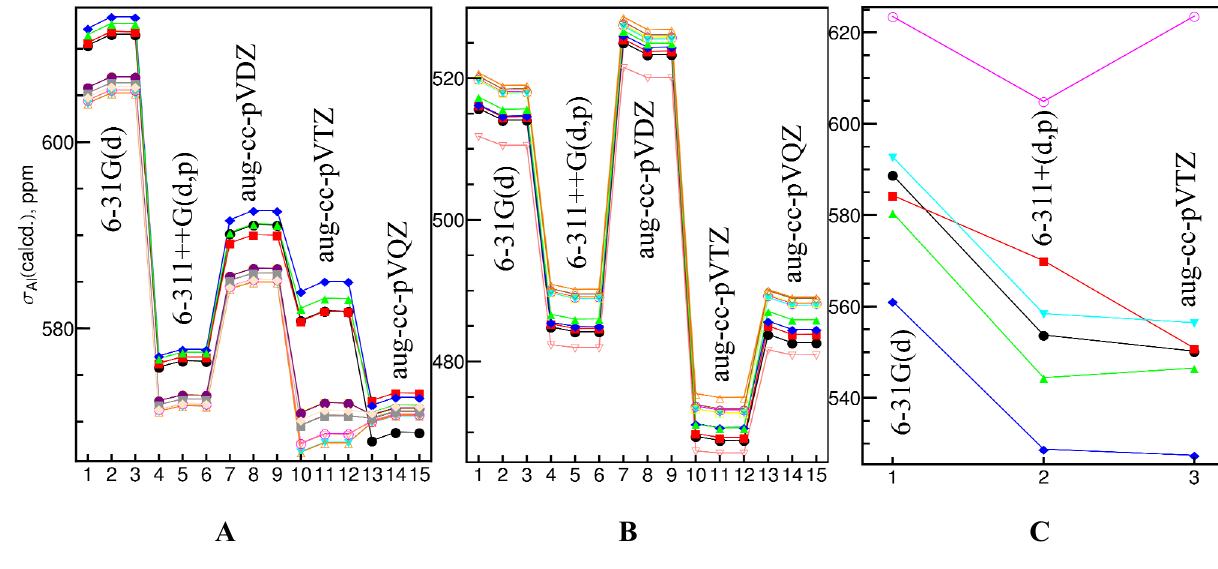
Figure 2. Calculated 27 Al shielding constants using the GIAO method with the B3LYP ) ] 3+ ( A ), functional with different basis sets in optimized geometries of [Al(OH 2 6 [Al(OH) ] − ( B ) and other complexes ( C ). The basis sets were labeled on the graphs. In 4 Panels A and B , there are three data points for each basis set which represent the values calculated in vacuum, in the PCM environment of water and methanol. Twelve geometries in A were obtained at the B3LYP/aug-cc-pVQZ, B3LYP/aug-cc-pVTZ, B3LYP/aug-cc-pVDZ and B3LYP/6-311++G(d,p) levels in vacuum, in the PCM environment of methanol and water, and the data sets are colored in black, red, blue, green, cyan, magenta, yellow, brown, orange, pink, purple and gray, respectively. The last geometry in A , which is in light orange color, was obtained at the B3LYP/6-31G(d) level in the PCM environment of water. Ten geometries in B were obtained at the B3LYP/aug-cc-pVQZ, B3LYP/aug-cc-pVTZ, B3LYP/aug-cc-pVDZ and B3LYP/6-311++G(d,p) levels in vacuum, at the B3LYP/ aug-cc-pVQZ and B3LYP/aug-cc-pVTZ levels in the PCM environment of methanol, and at the B3LYP/aug-cc-pVQZ, B3LYP/aug-cc-pVTZ, B3LYP/aug-cc-pVDZ and B3LYP/ 6-31G(d) levels in the PCM environment of water, and the data sets are colored in black, red, blue, green, cyan, magenta, yellow, brown, orange and pink, respectively. Six ] 3 − , [AlF ] 3 − , [Al(EDTA)] − , Al(lactate) , complexes in C are [Al(oxalate) 3 6 3 (OH ) ] − and [Al(N ≡ CCH ) ] 3+ , respectively. All the values obtained with a [Al(malonate) 2 2 2 3 6 same geometry are connected with straight